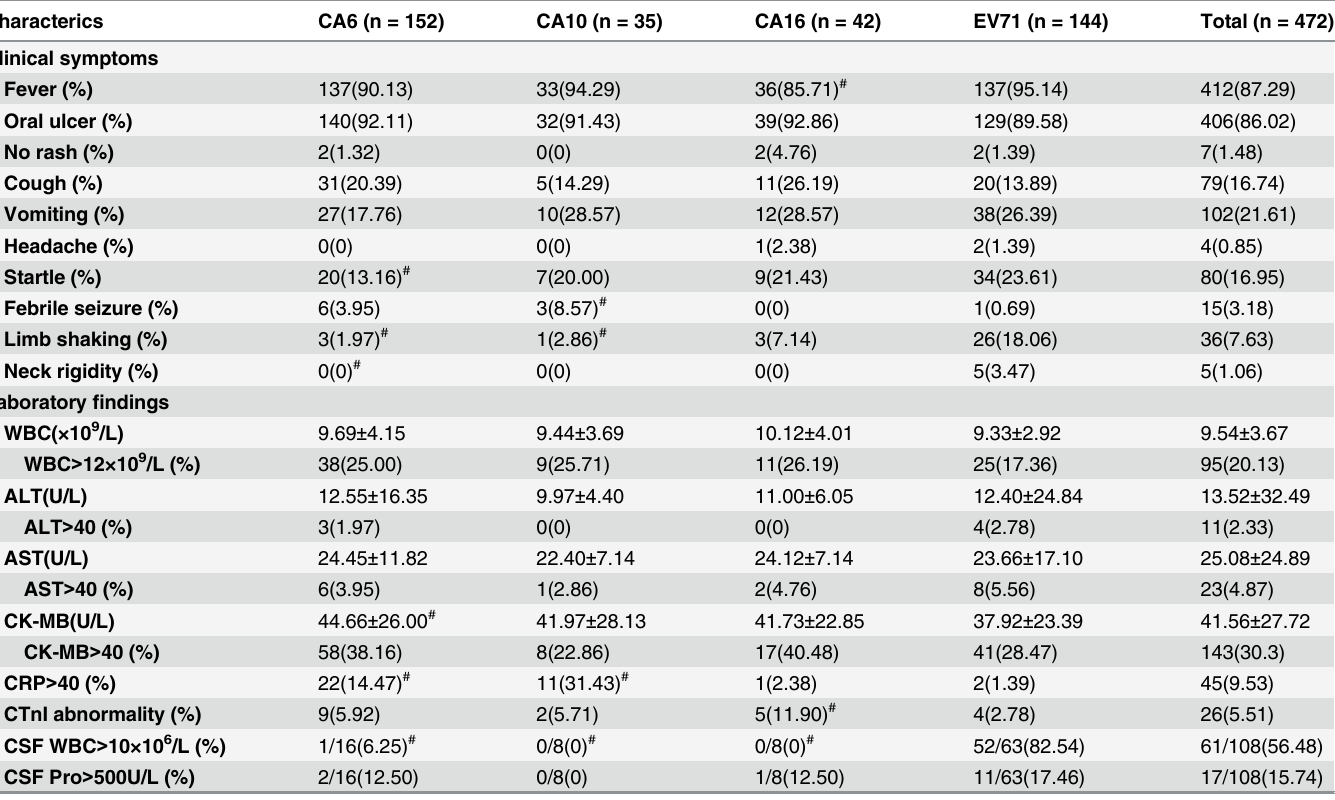
detection rate of CA10 was as high as 7.5%. To clarify the genetic characteristics, phylogenetic trees based on partial VP1 sequences from CA6 and CA10 strains were constructed. The repre- sentative sequences used in this study, that available from Genbank, still formed an indepen- dent cluster in the same genogroup as that in the other studies [26,27]. All our CA6 strains were quite divergent and showed four different clusters, which indicates there may have differ- ent transmission chains in Shanghai. The majority of CA6 strains belonged to cluster 4 and Table 2. Comparison of the clinical symptoms and laboratory findings of HFMD patients with different enterovirus infection.